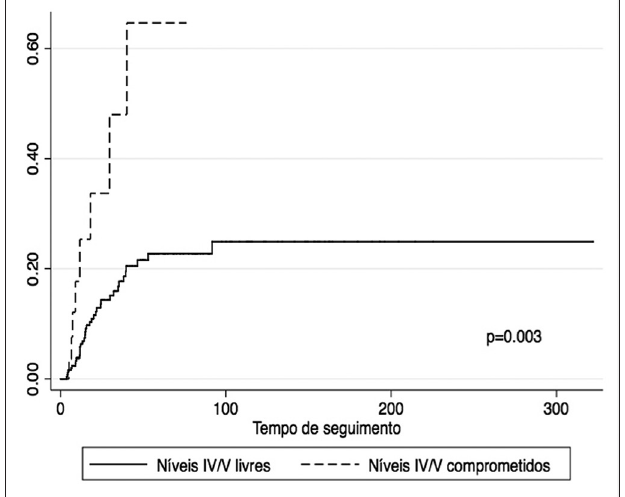
Figura 2. Curva de risco acumulativo de Nelson-Aalen para a ocorrên - cia de metástases sistêmicas pela presença de linfonodos metastáticos em nível IV/V.